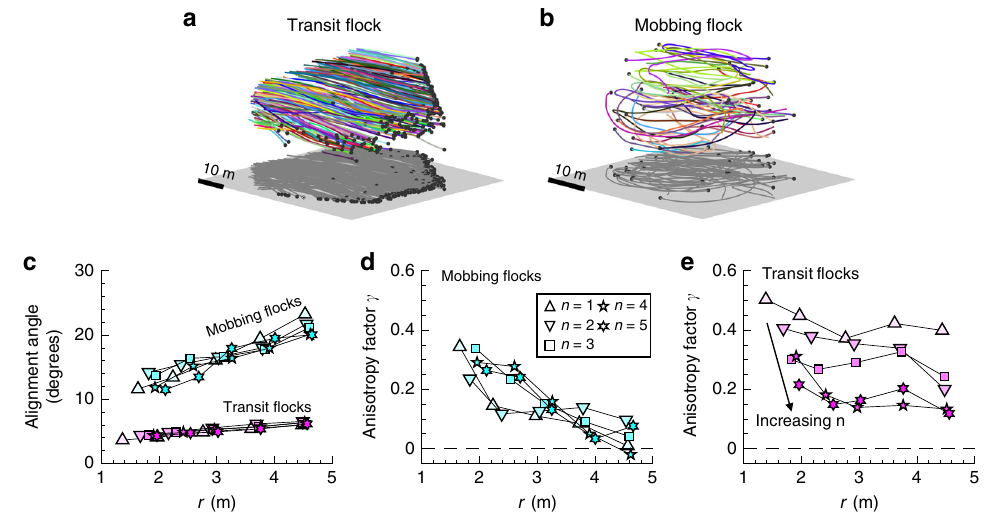
Fig. 1 Metric interactions in transit fl ocks and topological interactions in mobbing fl ocks. a Jackdaw trajectories in a sample transit fl ock. b Jackdaw trajectories in a sample mobbing fl ock. c Alignment angle between a focal bird and its neighbours. d , e Anisotropy factor γ for the distributions of neighbours relative to a focal bird for d mobbing and e transit fl ocks. r is the distance between the focal bird and its neighbour, and n is the topological rank. In a , b coloured lines show the jackdaws ’ three-dimensional (3D) trajectories, and the black dots show their positions in fl ocks at the fi nal time step. The grey planes are arbitrary horizontal planes (that is, perpendicular to the direction of gravity). Data in c , d are calculated from 10 mobbing fl ocks and 6 transit fl ocks. Standard errors are smaller than the symbol